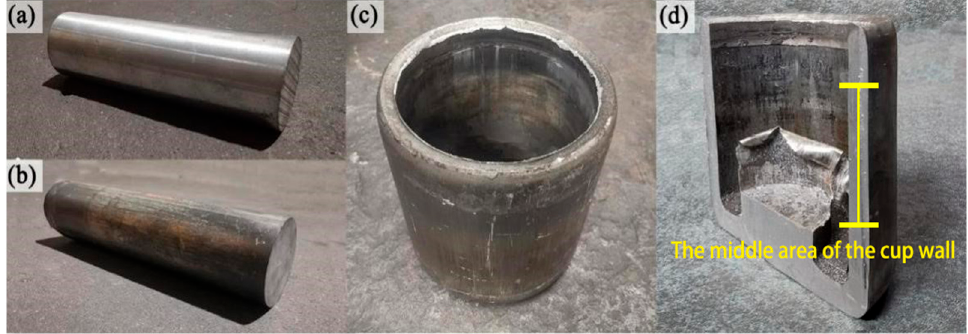
Figure 2. Schematic diagram of the formed part. ( a ) initial billet, ( b ) after upsetting and extrusion billet, ( c ) formed parts, and ( d ) the section of formed parts. Table 2. The plan of the heat treatment